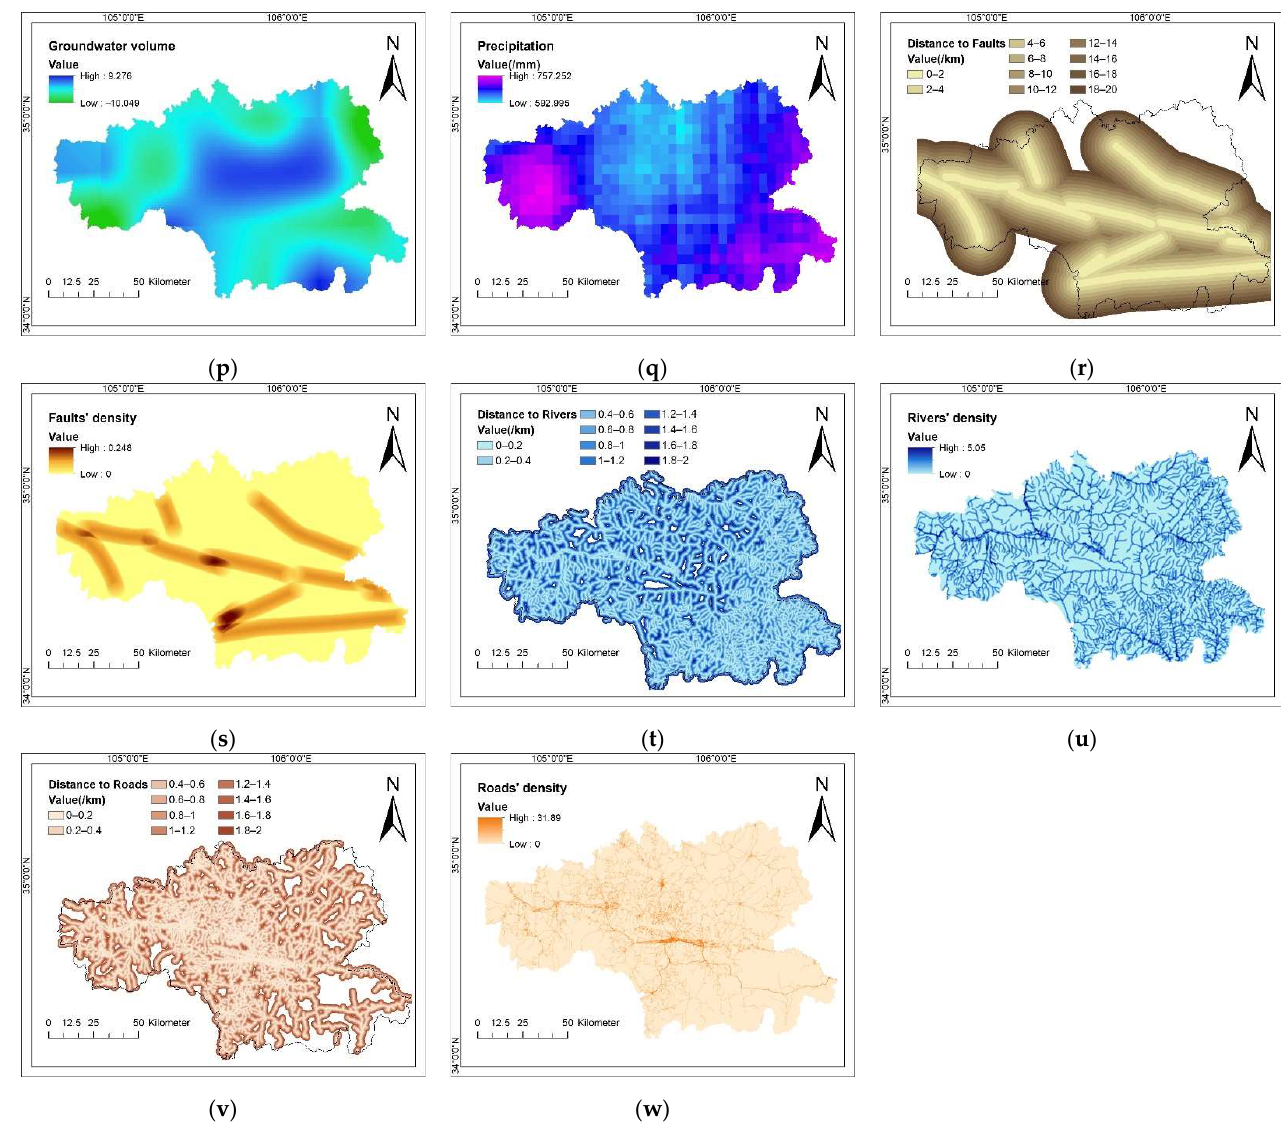
Figure 5. Graphics of the conditioning factors: ( a ) Slope; ( b ) Aspect; ( c ) Elevation; ( d ) TWI; ( e ) Curvature; ( f ) Profile curvature; ( g ) Plan curvature; ( h ) TRI; ( i ) Cumulative solar radiation; ( j ) Lithology; ( k ) Land cover; ( l ) NDVI; ( m ) NDBI; ( n ) NDWI; ( o ) MNDWI; ( p ) Ground water volume; ( q ) Precipitation; ( r ) Distance to faults; ( s ) Fault density; ( t ) Distance to rivers; ( u ) River density; ( v ) Distance to roads; ( w ) Road density.